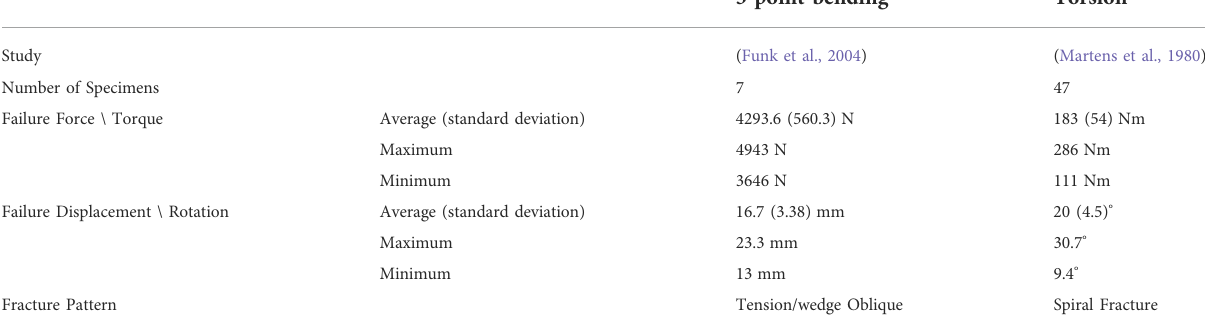
TABLE 2 Whole bone femur experimental